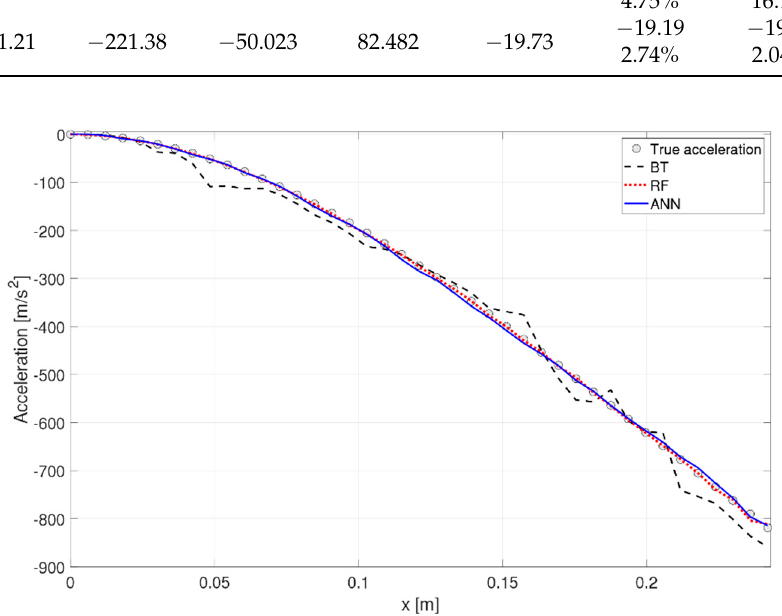
Figure 11. Deformed shape at t = 3.7498 s.